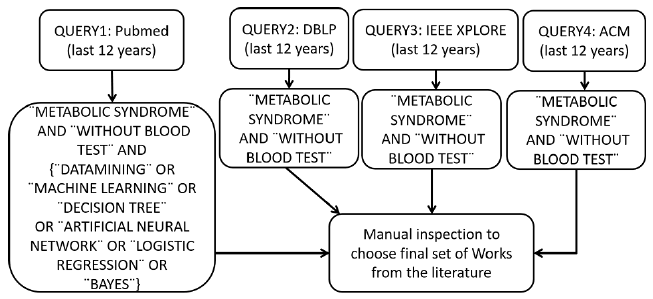
Figure 3. Selection criteria for choosing classification models for MetS diagnosis from the literature.